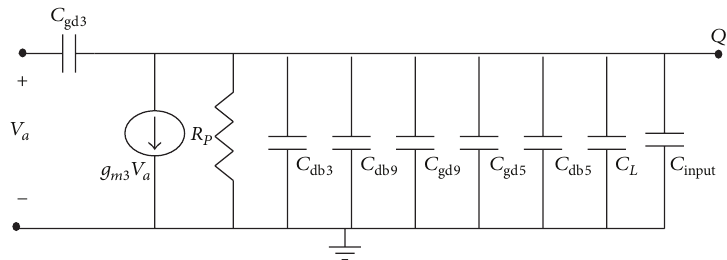
Figure 4: Linear half circuit (with low-to-high transition on